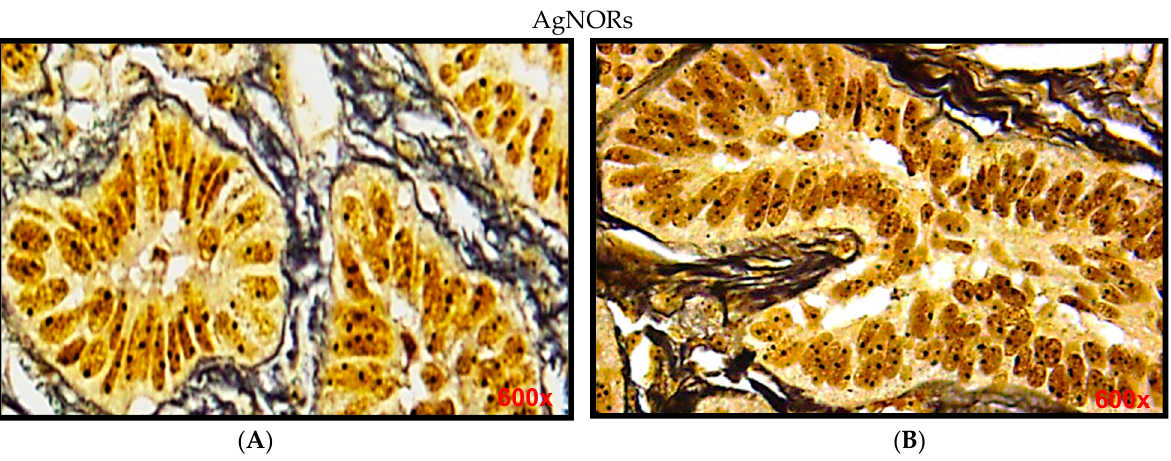
Figure 1. ( A ) Photomicrographs of ameloblastoma showing black dots in the nucleus of peripheral columnar ameloblast-like cells and central stellate shaped cells; ( B ) photomicrographs of ameloblastic fibroma showing black dots in the nuclei of peripheral columnar ameloblast-like cells and central stellate-shaped cells.